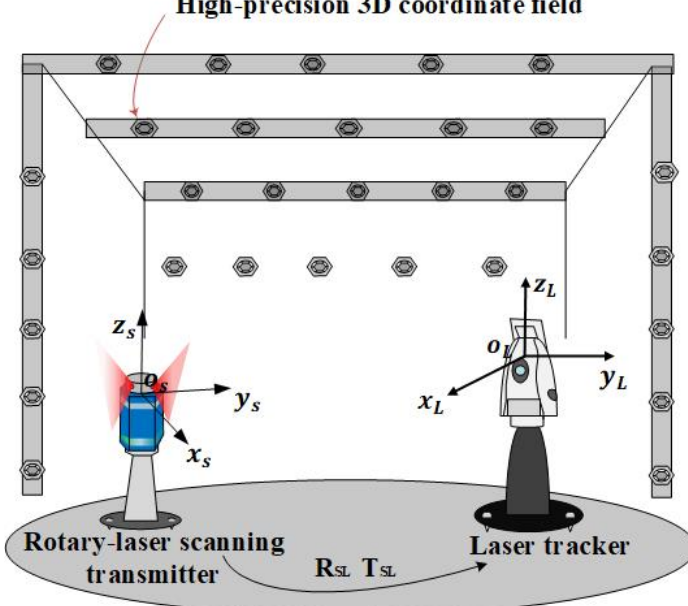
Figure 5. Layout of high-precision 3D control field, laser tracker, and rotary-laser scanning transmitter.